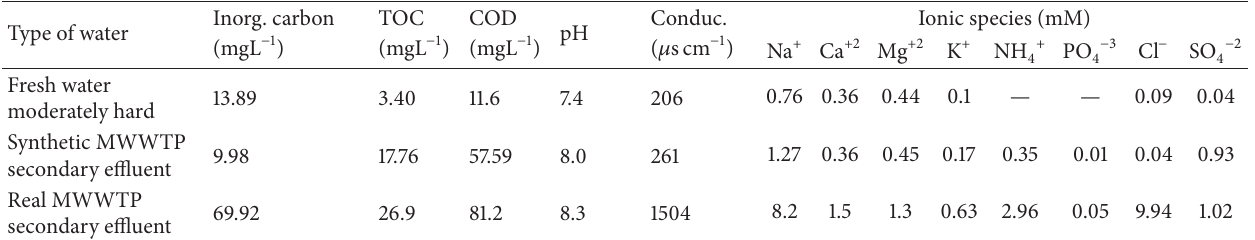
Table 1: Physical and chemical characteristics of the different types of